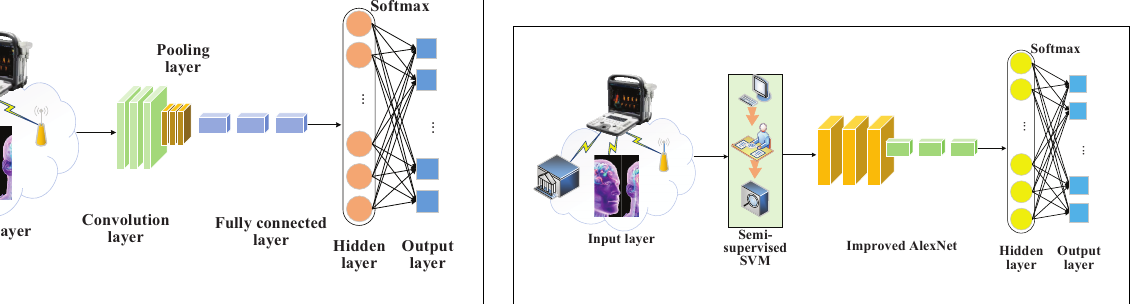
FIGURE 4 | Schematic diagram of the brain image DTs diagnosis and forecasting model based on S3VMs and improved